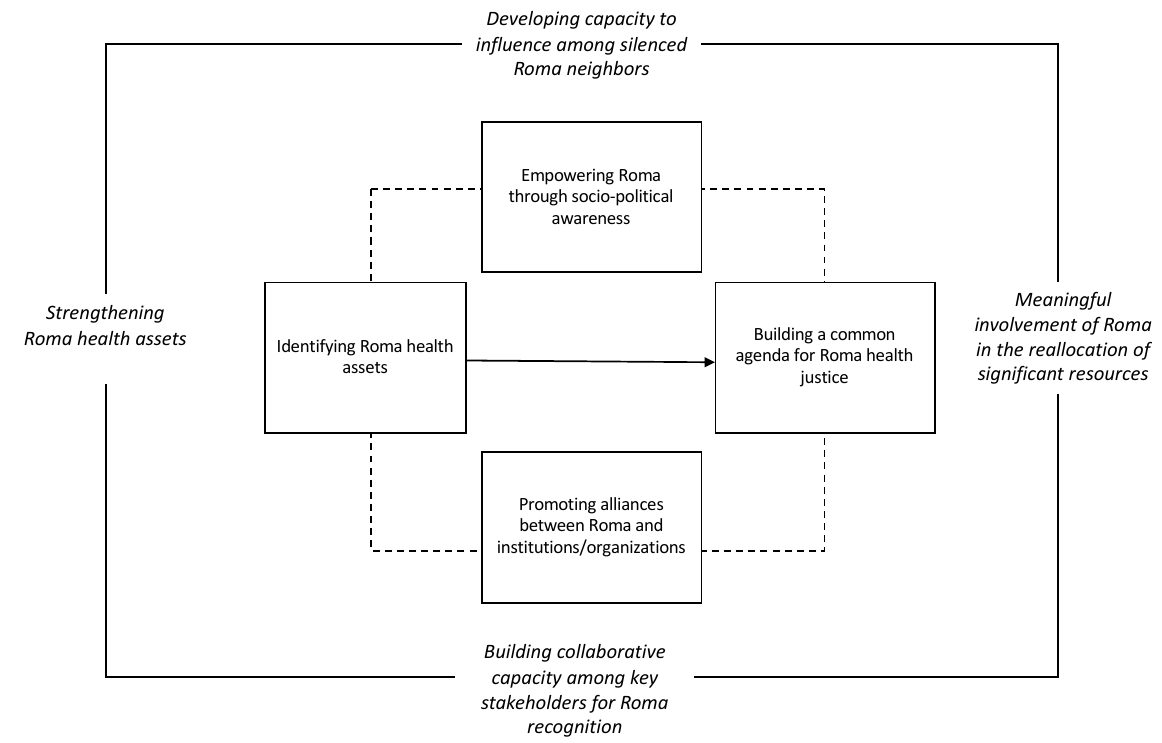
Figure 1. Community-based participatory action research process for Roma health justice at the local level .